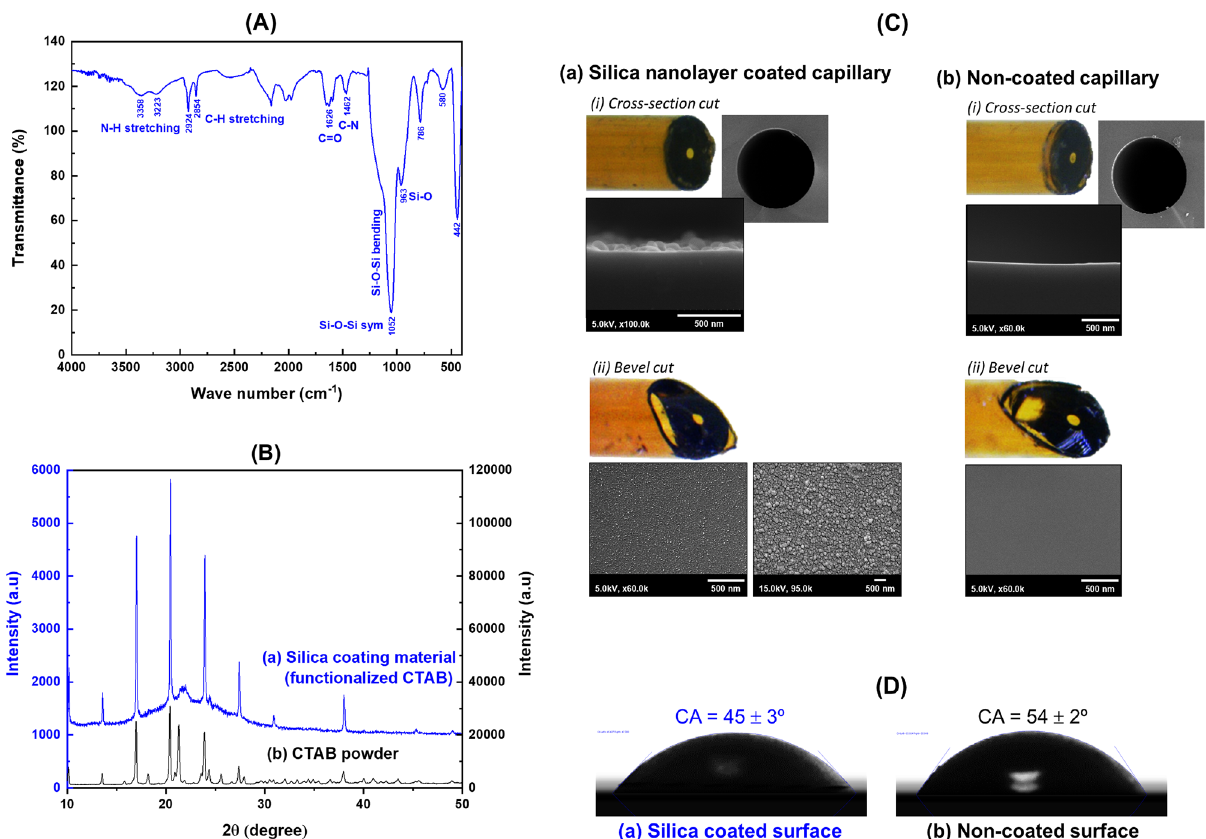
Figure 3. ( A ) FT-IR spectra of silica coated material (functionalized CTAB). The spectrum of the coating material is from a porous material prepared using the hydrothermal sol–gel procedure with the selected sol–gel formulation. ( B ) XRD patterns of (a) silica coating material (functionalized CTAB) and (b) CTAB powder. ( C ) In-situ SEM images of inner surface morphology of capillaries: (a) silica nanolayer coated capillary and (b) non- coated capillary. The thickness of the layer is observed from the horizontal cut (i) and the morphology of the surface observed from the bevel cut (ii). ( D ) Contact angle measurements of (a) silica coated surface (b) non- coated surface (glass slide used as substrate), showing the contact angles as measured by ImageJ